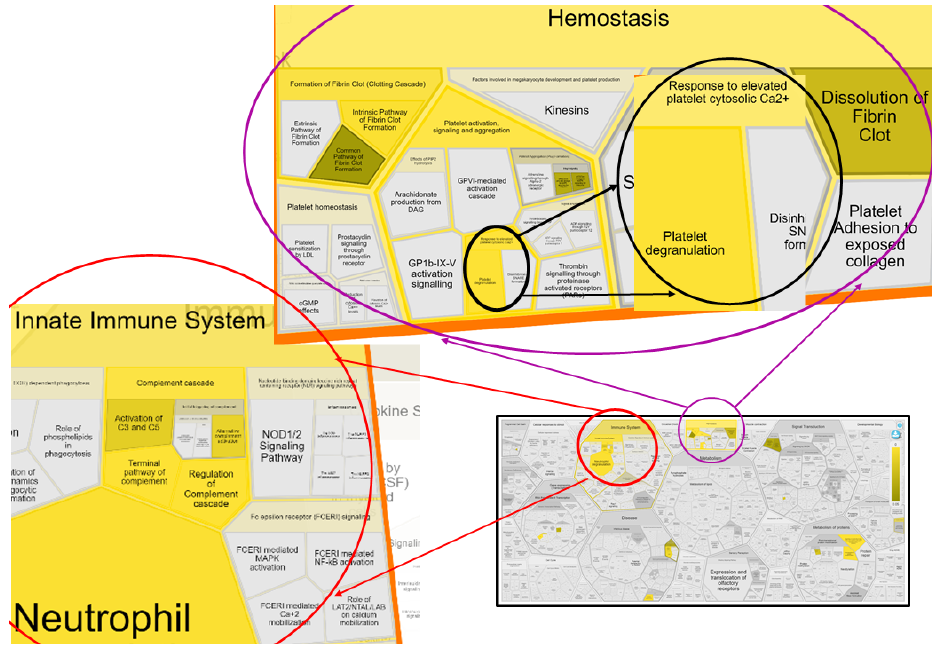
Figure 5. Reacfoam representation of seven biological pathways with ≥ 5 associated gene hits